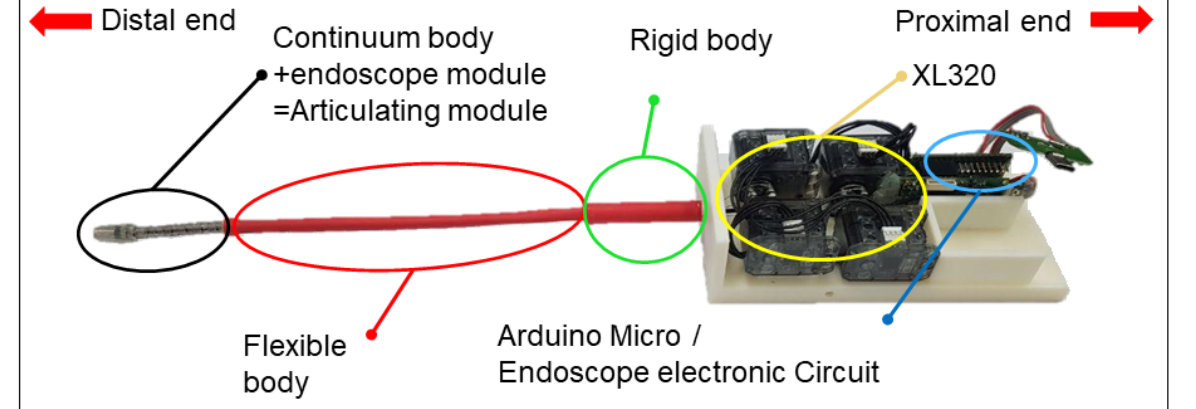
Figure 3. Cut-away assembly of the device, showing the actual structure. The long flexible distal end is composed of the continuum, flexible, and rigid